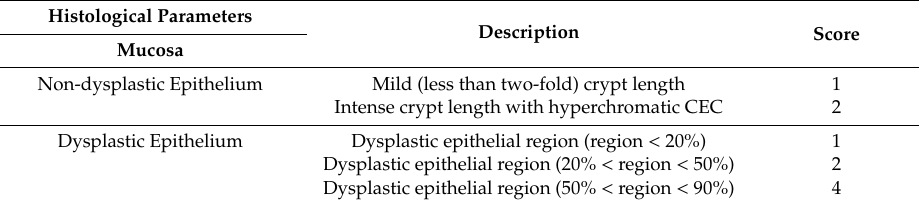
Table 1. Scores of histopathological hyperplasia.